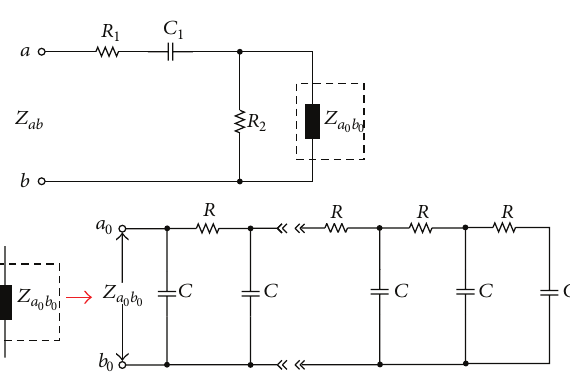
Figure 11: Ultracapacitor model described by only 5 real